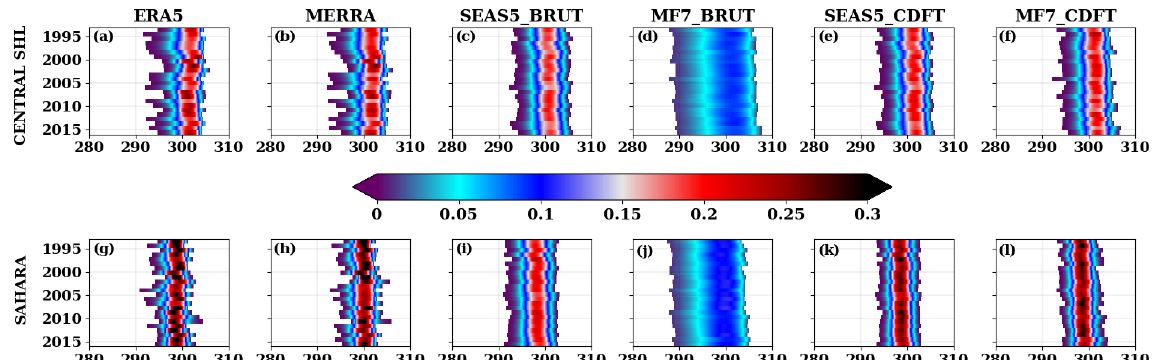
Figure 7. Distribution of yearly T850 over the JJAS period during 1993-2016 over the (a–f) central SHL box and (g–l) Sahara. ERA5, MERRA, SEAS5_BRUT and MF7_BRUT here correspond to the intensity of the SHL using ERA5 and MERRA for the reanalyses; SEAS5 and MF7 raw forecasts respectively. SEAS5_CDFT and MF7_CDFT refer to the intensity of the SHL using SEAS5 and MF7 seasonal forecasts respectively bias corrected using ERA5. The computation was made using the ensemble members of the forecast models. The y axis indicates time in years and x axis T850 in kelvins. The color bar indicates the probability of occurrence.